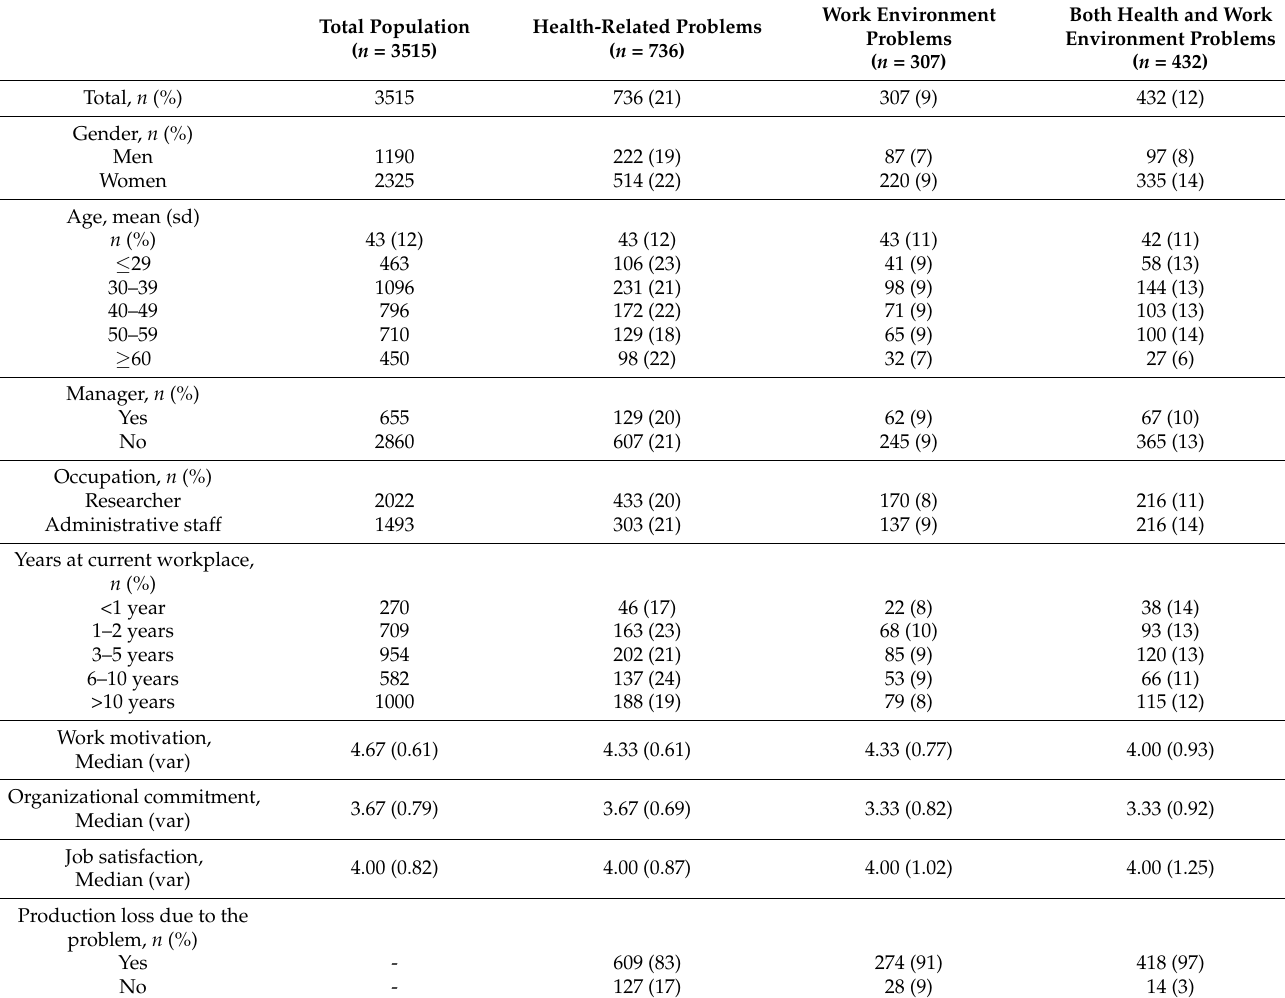
Table 1. Description of the study